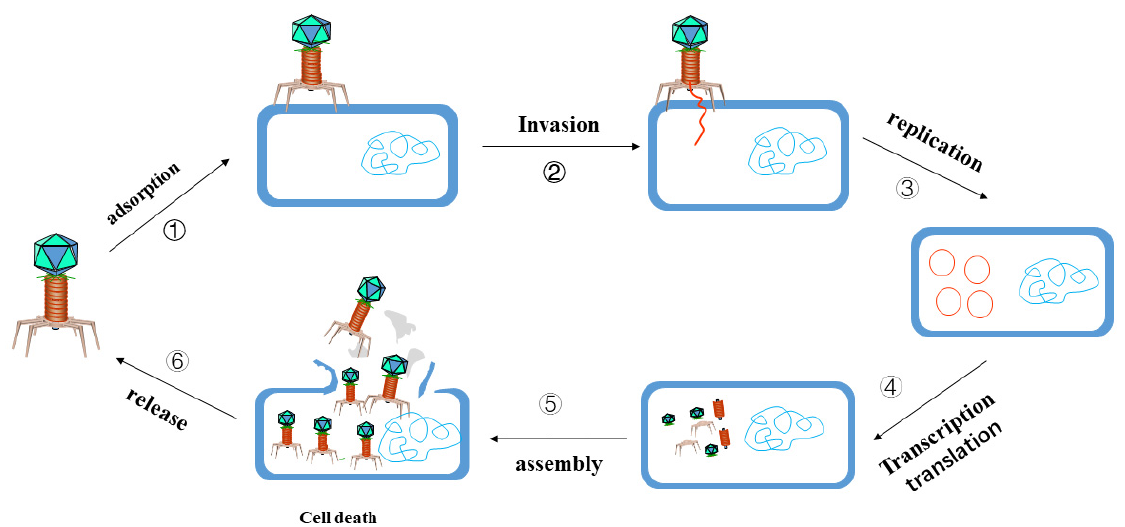
Figure 2. The phage infection process refers to the following six steps [108] : (1) adsorption: the process of specific binding between protein attached by phage and host surface receptor protein. Dif- ferent phages match different cell receptors, which exist on the cell wall, capsule, flagella or sexual pili. (2) Invasion: when finding the host, bacteriophage will pierce the surface of the bacteria using its tail filament, and then inject its genetic information into the bacteria through the tail, with the capsid left outside the cell [109] ; (3) Synthesis of bacteriophage macromolecules: The nucleic acid